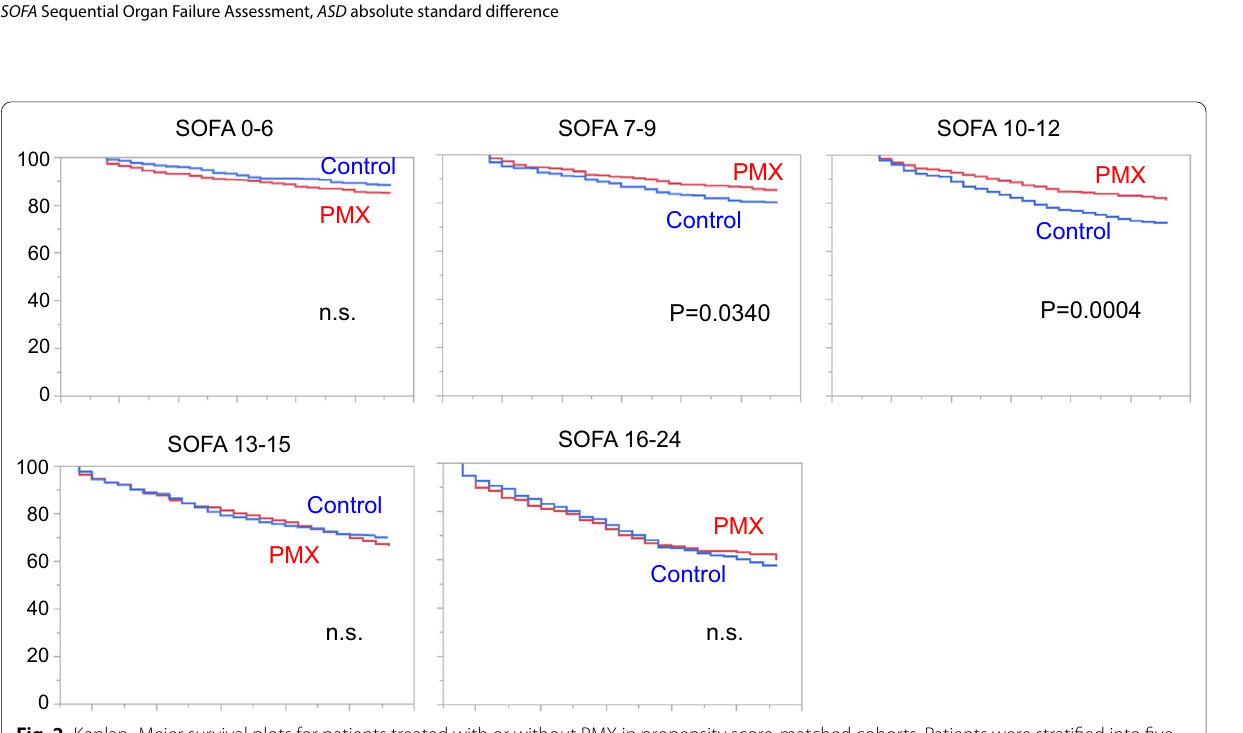
SOFA Sequential Organ Failure Assessment, ASD absolute standard difference